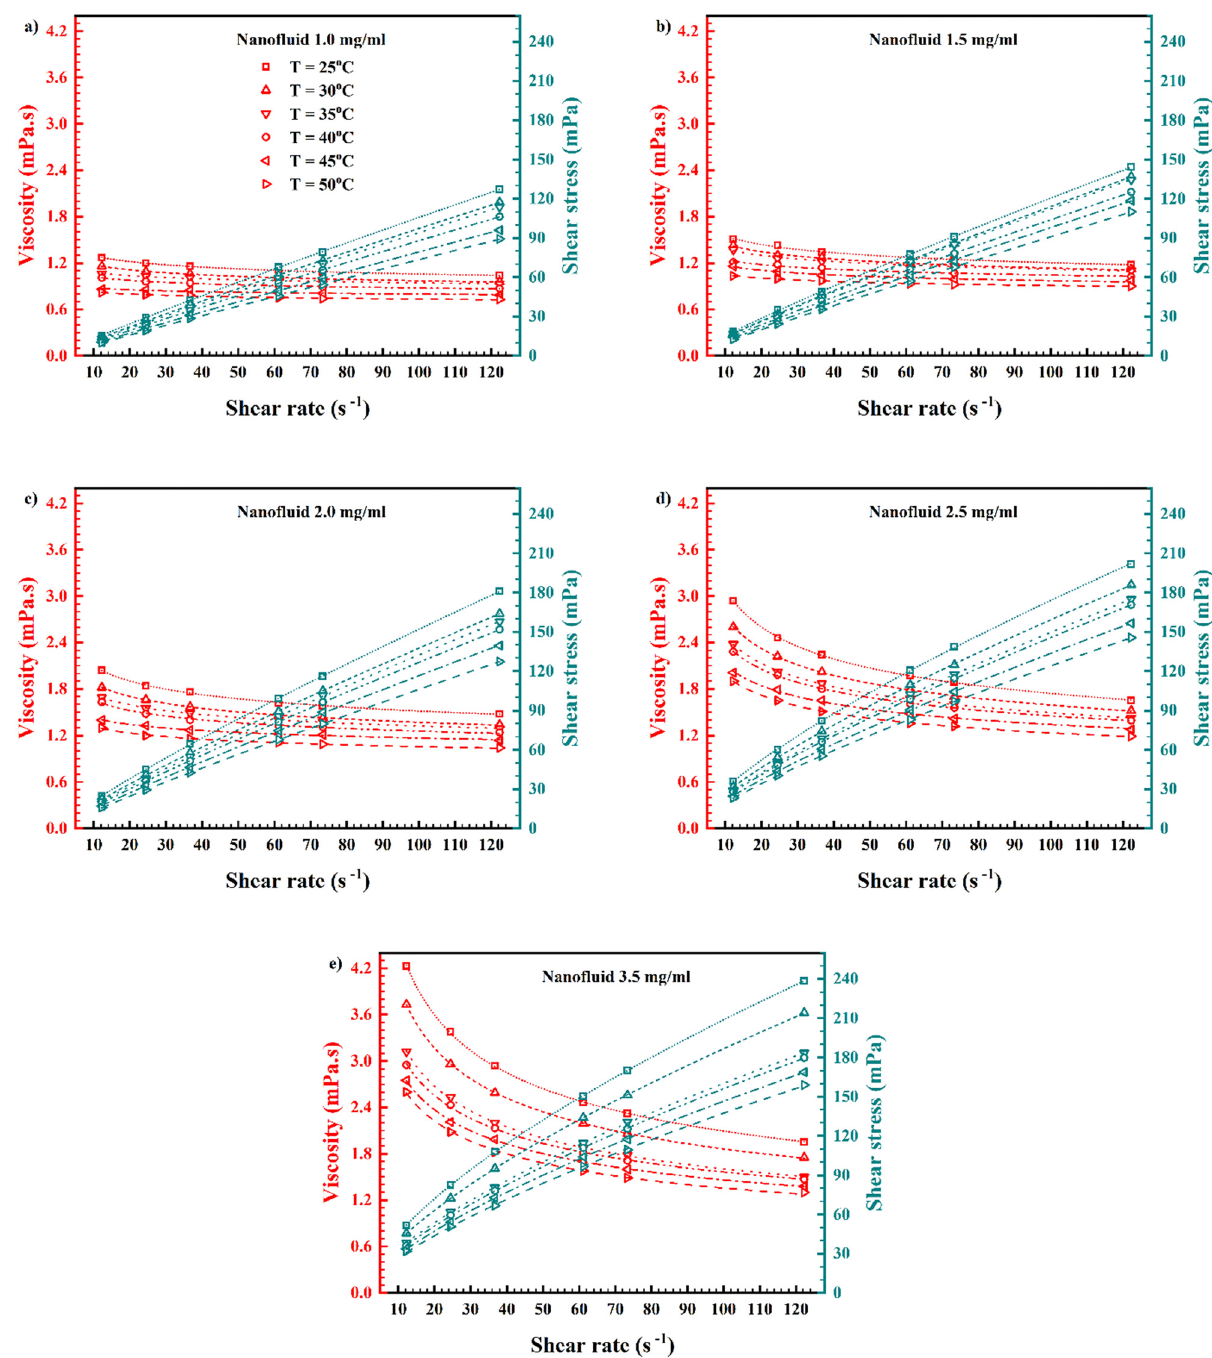
Figure 14: Viscosity and shear stress values against SR for di ff erent mass concentrations and